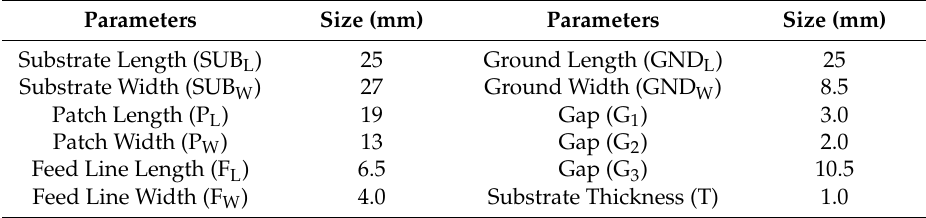
Figure 1. Proposed antenna schematic ( a ) front view ( b ) back view of graphic structure and fabricated prototype ( c ) front view ( d ) back view on flexible nickel aluminate material at 42% concentration of nickel. Table 1. Design specification of the proposed flexible antenna at 42% concentration of nickel.